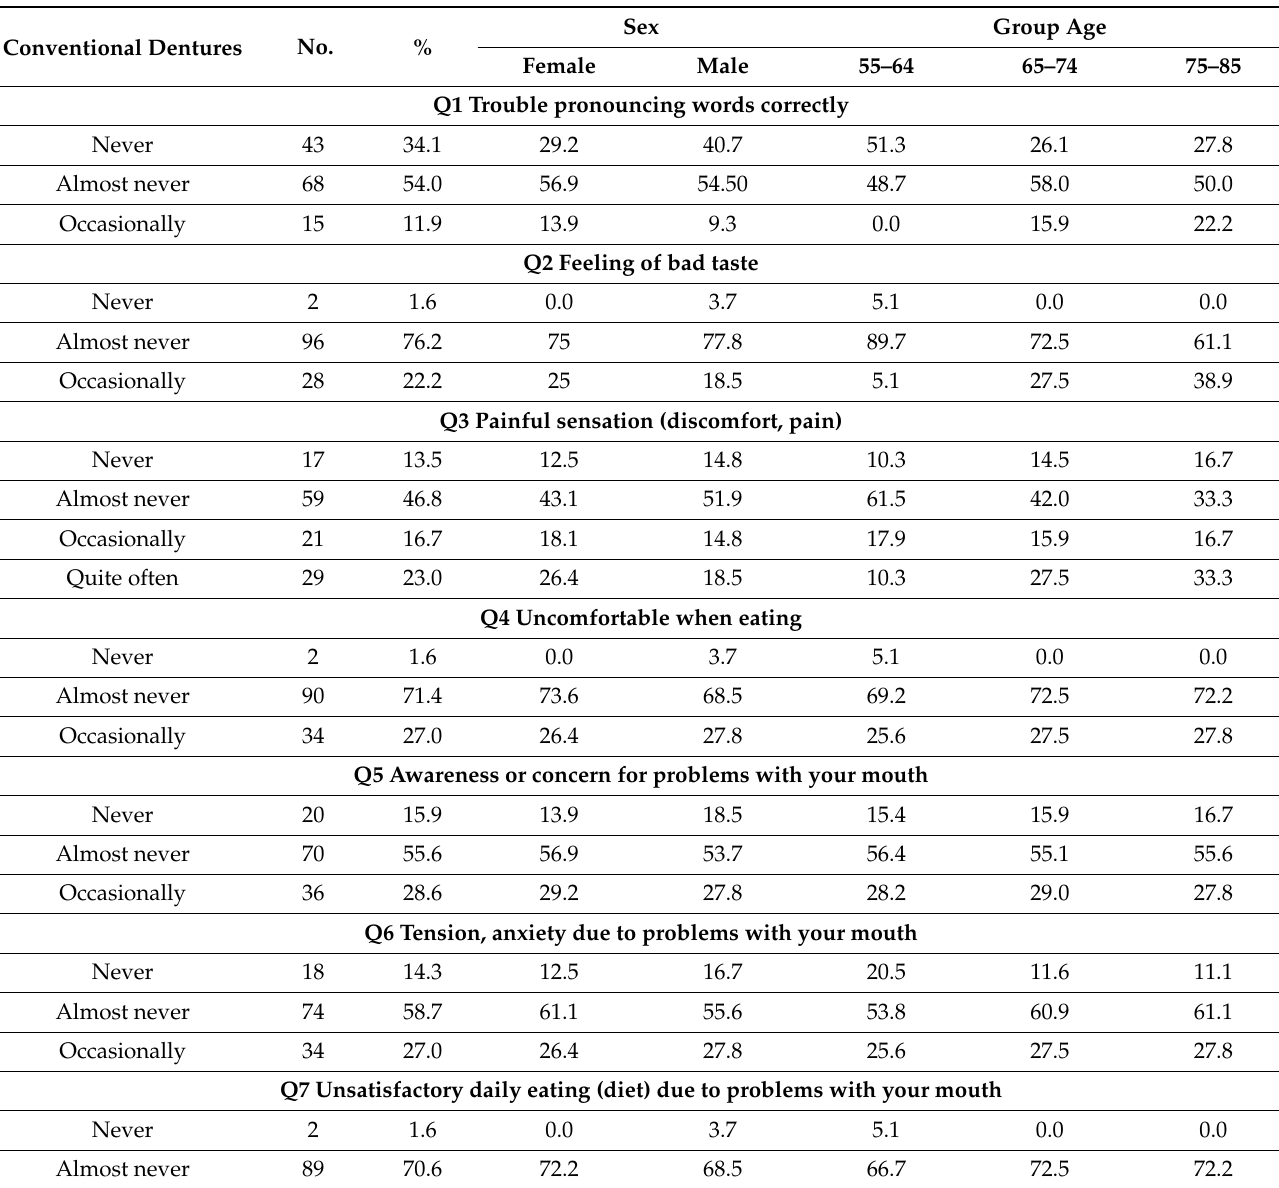
Table 3. Distribution of the answers to the OHIP questionnaire for conventional denture